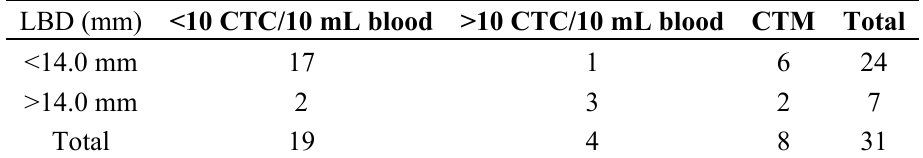
Table 2. Correlation of CTC count with lager basal diameter LBD.